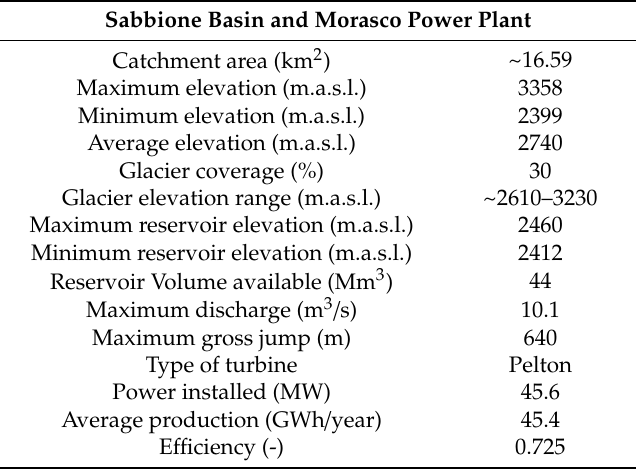
Figure 1. ( a ) Geographical location of the basin in Piedmont region; ( b ) digital terrain model (DTM) of the Sabbione catchment. Table 3. Main features of the Sabbione catchment and Morasco power plant